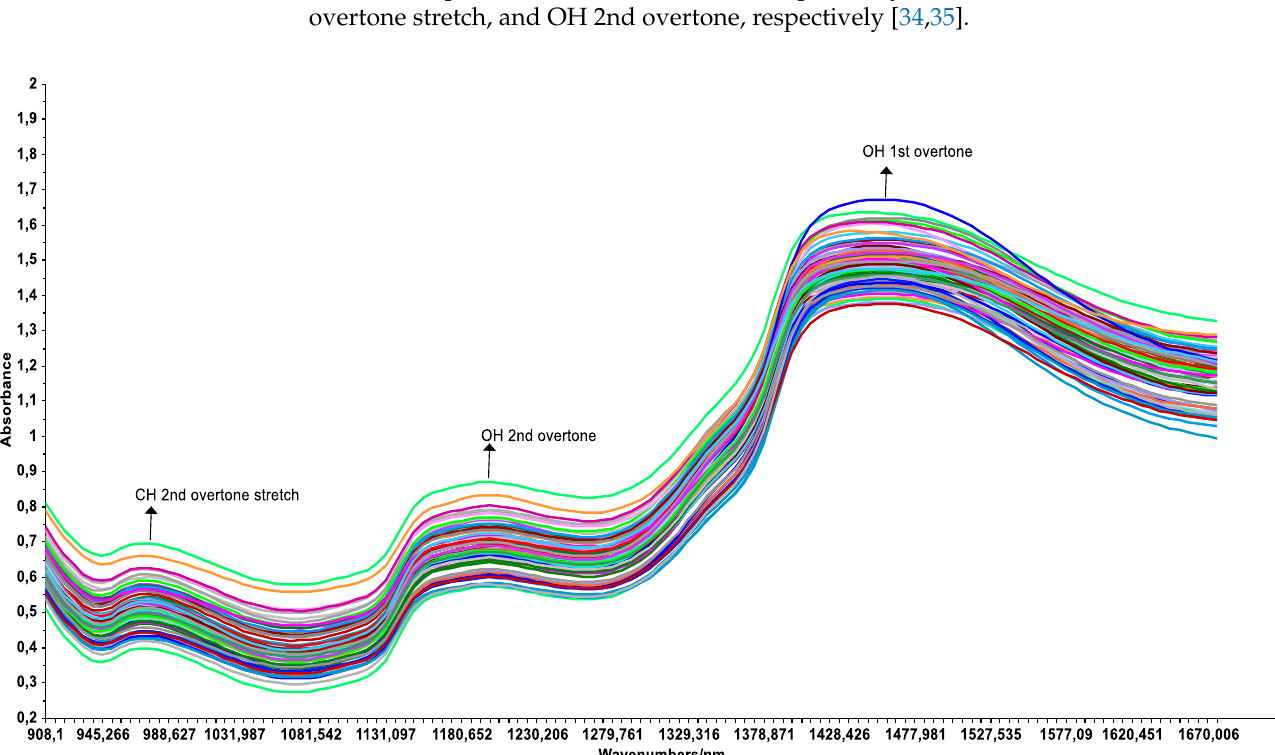
Table 2. Range, mean standard deviation, and coefficient of variation for the DM, TP, FRAP, and CUPRAC datasets.